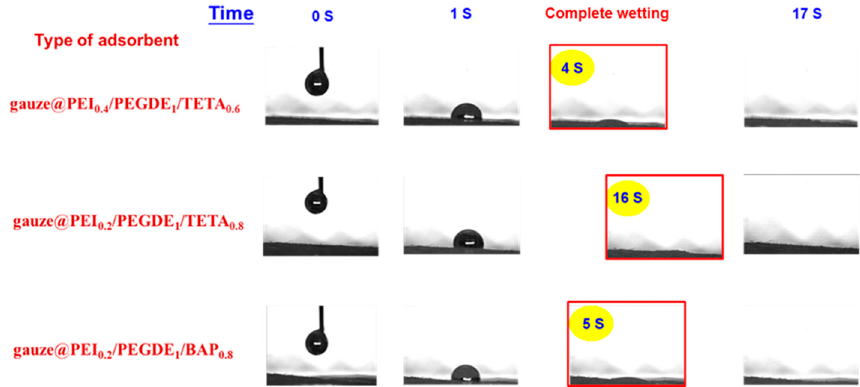
Figure 1. Images of the time required for the complete wetting of water droplet on various polymer-coated gauze.